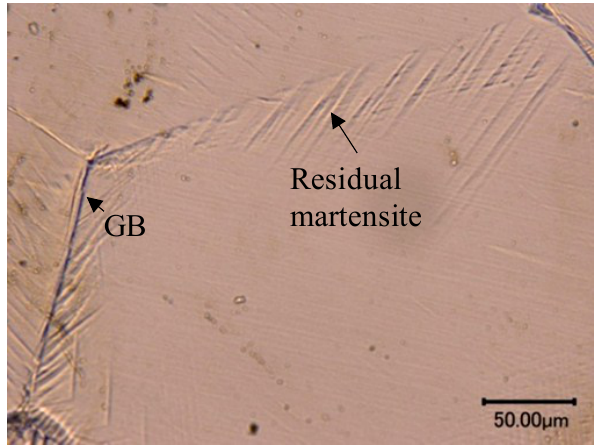
Figure 10. Optical micrograph showing residual martensite formed around grain boundaries after